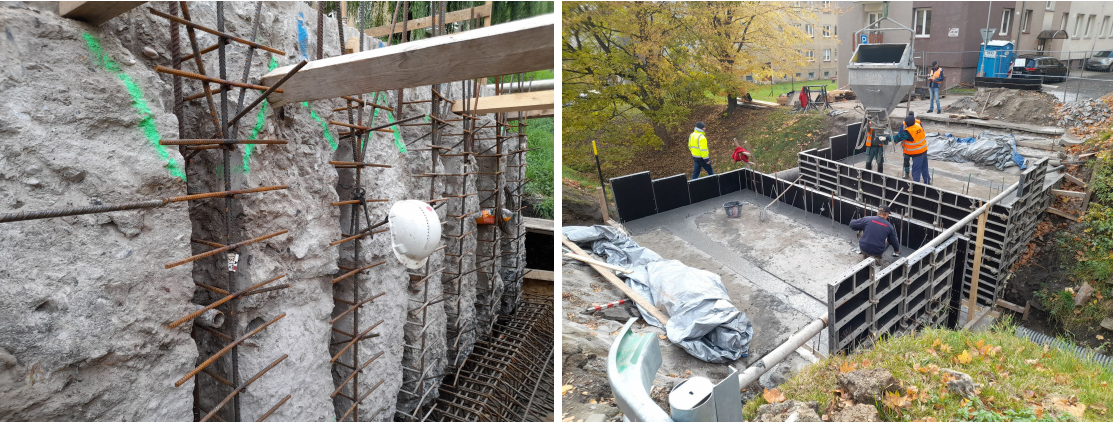
Figure 10. Ribbed UHPFRC layer around existing abutments and wing walls (left – preparation of the shape and reinforcement, right – casting the UHPFRC layer) – Meziboří at